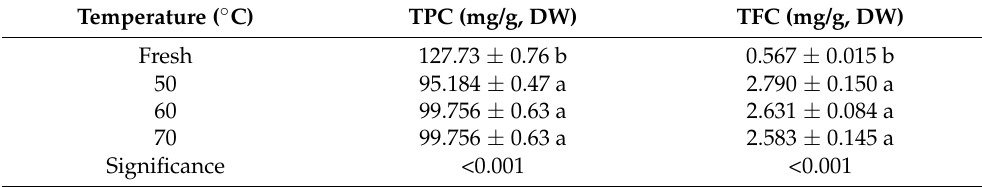
Table 6. Total phenolic and flavonoid contents in fresh and dried linden